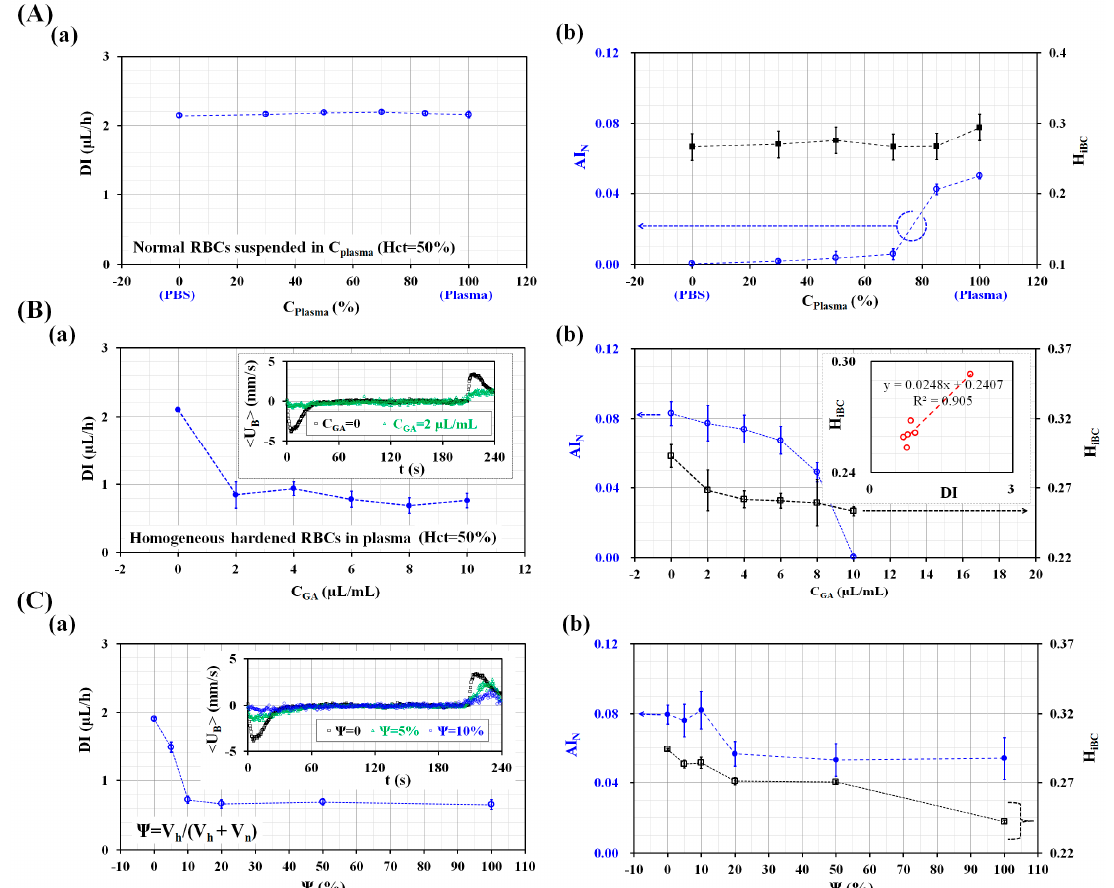
Figure 4. Performance evaluation of the proposed method. ( A ) Variations of blood biophysical properties with respect to the concentration of plasma (C plasma ). Blood was supplied into a microfluidic device at a periodic on–off profile (i.e., Q 0 = 1 mL/h, T on = 210 s, and T off = 30 s). The hematocrit of blood was adjusted by normal RBCs into a specific concentration of plasma. ( a ) Variation of DI with respect to C plasma = 0, 25%, 50%, 70%, 85%, and 100%. ( b ) Variations of AI N and H iBC with respect to C plasma . ( B ) Detection of homogeneous hardened blood composed of homogeneous hardened RBCs with GA solution. The hematocrit of hardened blood was adjusted to 50% by adding hardened RBCs into autologous plasma. ( a ) Variations of DI with respect to C GA = 0, 2 µ L/mL, 4 µ L/mL, 6 µ L/mL, 8 µ L/mL, and 10 µ L/mL. ( b ) Variations of AI N and H iBC with respect to C GA . ( C ) Detection of heterogeneous blood composed of normal RBCs and partially hardened RBCs. Here, normal RBC was hardened by dipping them into 2 µ L/mL GA solution. Then, the hematocrit of hardened blood and normal blood were adjusted to 50% by adding hardened RBCs and normal RBCs into autologous plasma. Specifically, a mixing ratio ( Ψ ) was defined as the ratio of hardened blood volume to total blood volume (i.e., Ψ = V h /[V h + V n ]). Here, V h and V n denote hardened blood and normal blood, respectively. ( a ) Variations of DI with respect to Ψ = 0, 5%, 10%, 20%, 50%, and 100%. ( b ) Variations of AI N and H iBC with respect to Ψ .